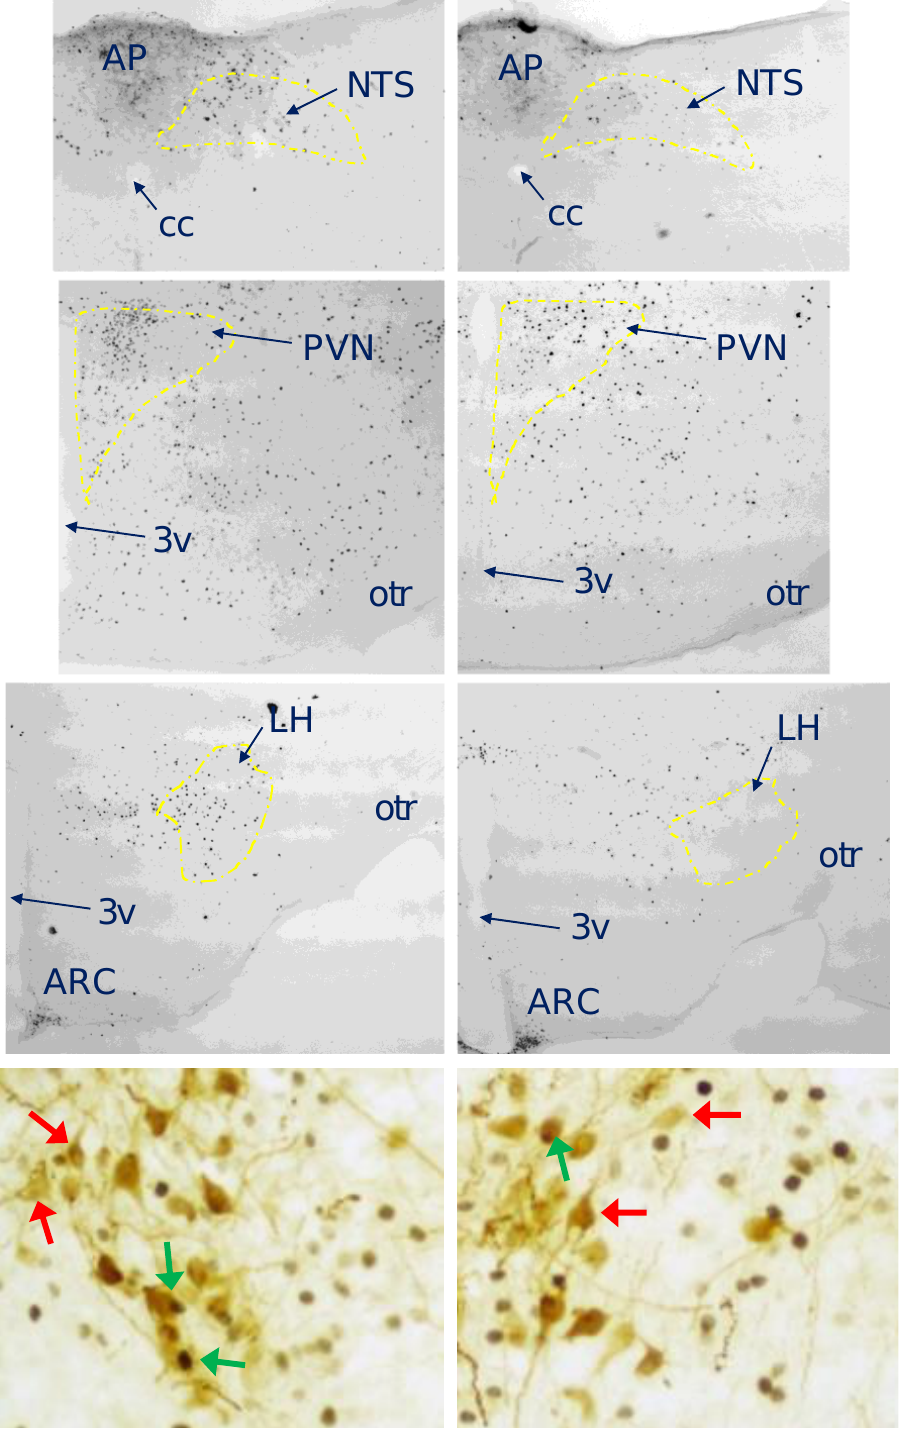
Figure 4. Photomicrographs depicting feeding-related brain sites (top three rows) and PVN OT neurons (bottom row) in which c-Fos immunoreactivity was different after ingestion of the same volume of the control 20:80 CM (left panel) vs. 60:40 (right panel) whey:casein milk formulation. 3v — third ventricle, AP — area postrema, ARC — arcuate nucleus, cc — central canal, NTS — nucleus of the solitary tract, otr — optic tract, LH — lateral hypothalamus; PVN — paraventricular hypothalamic nucleus; in the double-stained sections, red arrows point to OT cells devoid of c-Fos, whereas green arrows indicated c-Fos-positive OT neurons.